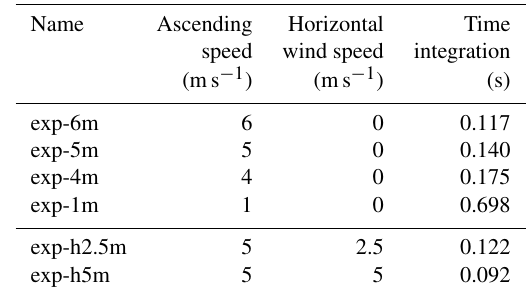
Table 2. Experimental CFD